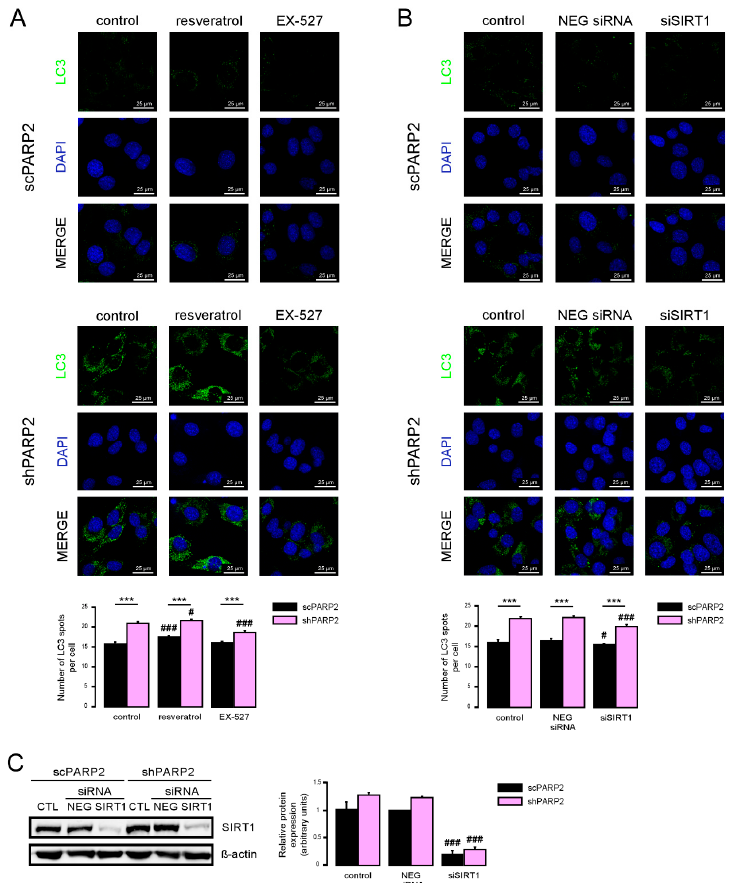
Figure 7. SIRT1 activation is a key determinant of the PARP2-mediated inhibition of autophagy. ( A ) scPARP2 and shPARP2 C2C12 cells were treated with 50 µM resveratrol or 25 µM EX-527 for 24 h ( n = 3). LC3 expression was assessed by confocal microscopy. Alexa Fluor 488-linked